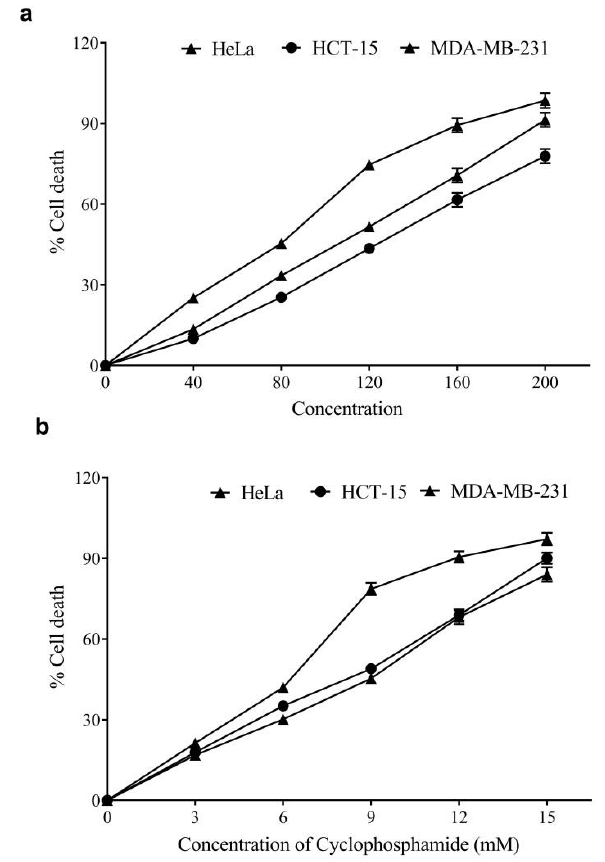
Figure 2. Anti-proliferative activity of OIM extract ( a ) and standard cyclophosphamide ( b ) on HCT15, and MDA-MB-231 HeLa, HCT15, and MDA-MB-231 cells.